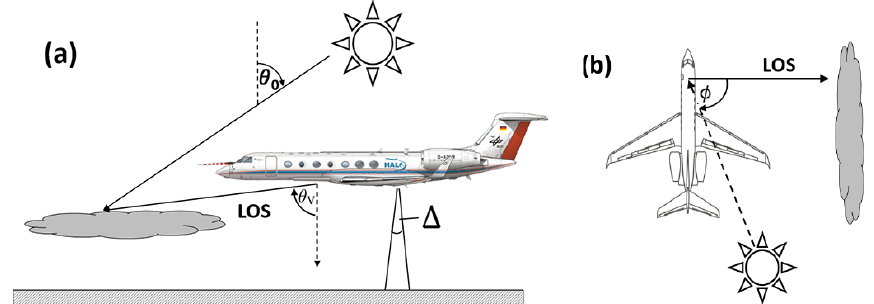
Figure 1. Illustration of the measurement geometry. (a) shows the side view with solar zenith angle θ 0 and the viewing angle θ V . The opening angle of the nadir looking radiance sensor of SMART is indicated by (cid:49) . The top view (b) shows the definition of the relative solar azimuth angle φ between the line-of-sight (LOS) and the Sun.